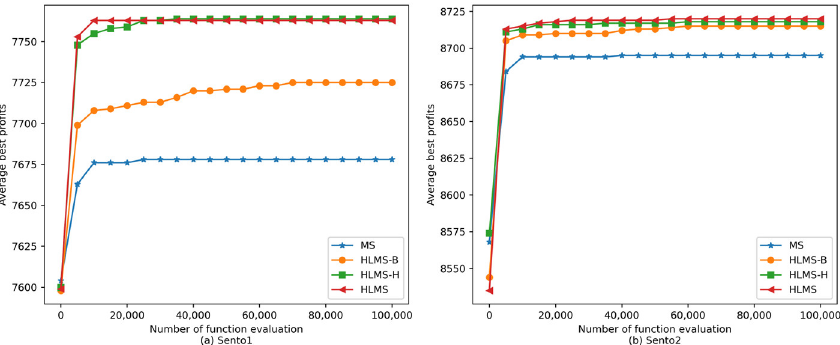
Figure 12. Convergence graphs of MS, HLMS-B, HLMS-H, and HLMS on Sento1 and Sento2.